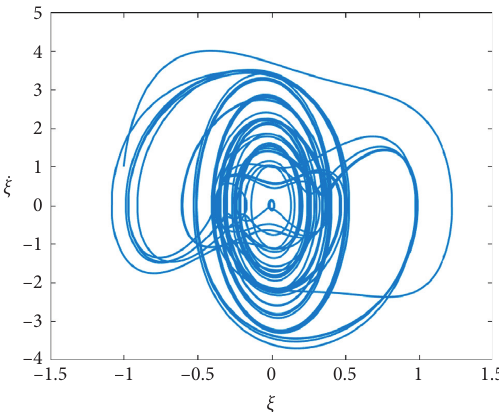
Figure 1: Phase plane trajectory of gyroscope